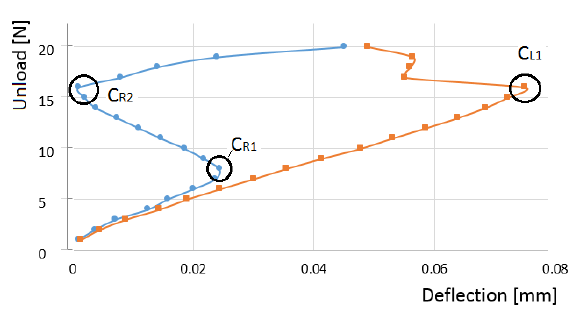
Figure 7: Residual deflection disruption after unloading. Source: Own study.